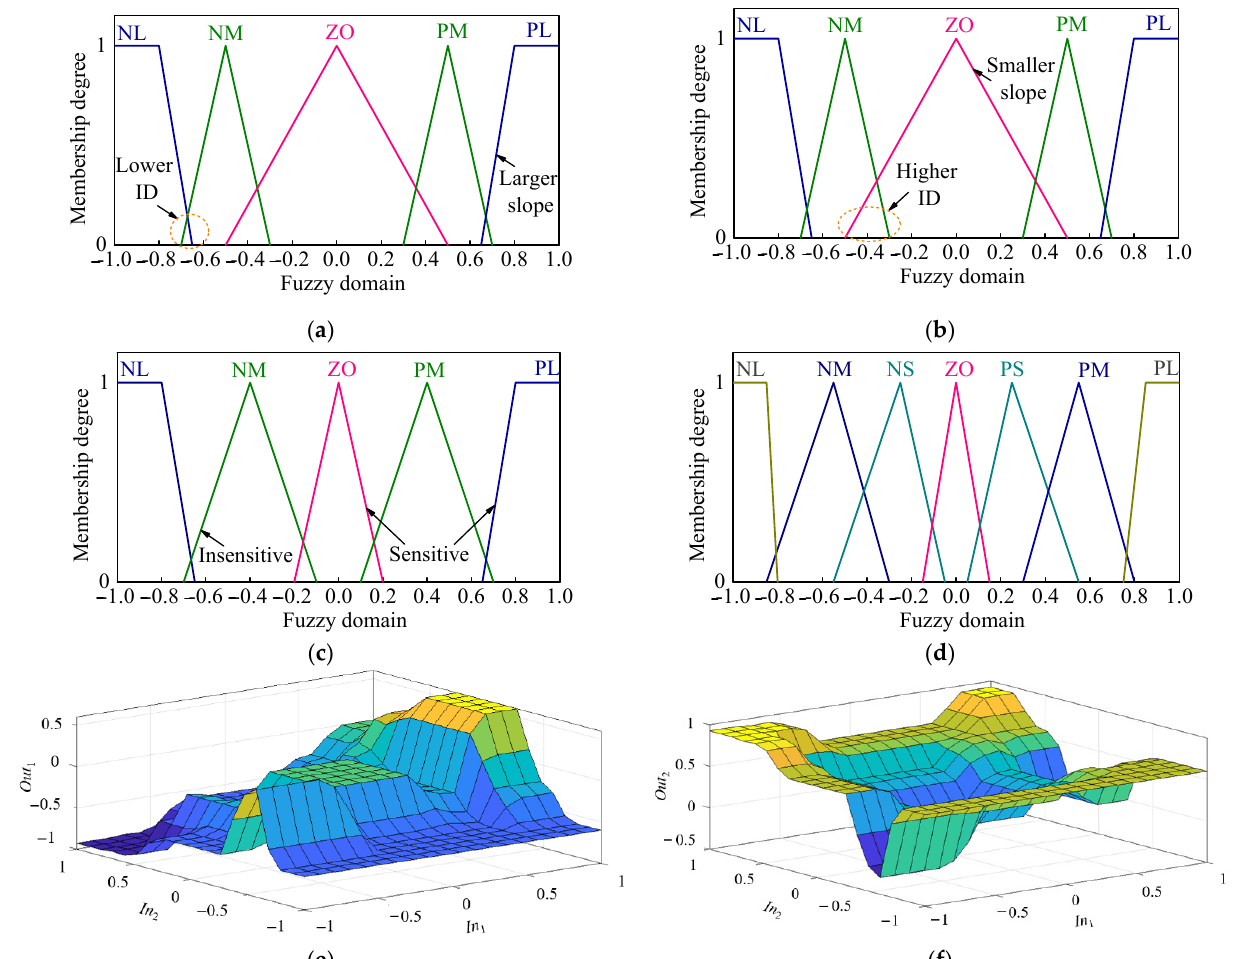
Figure 3. Fuzzy membership functions. ( a ) Membership functions for In 1 ; ( b ) Membership functions for In 2 ; ( c ) Membership functions for In 3 ; ( d ) Membership functions for the outputs. ( e ) Relationship between In 1 , In 2 and Out 1 in the form of surface view; ( f ) Relationship between In 1 , In 2 and Out 2 in the form of surface view.